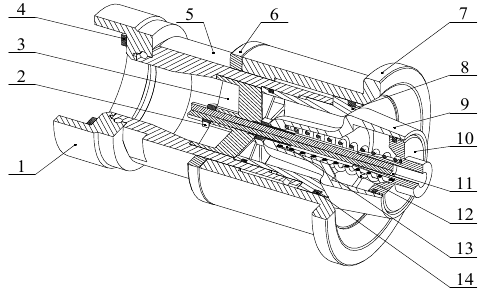
Figure 2. Structure of the new adaptive gun head. 1. Joint; 2. Nut; 3. Regulator; 4. Gasket; 5. Enclosure; 6. Ring; 7. Outer nozzle; 8. Inner nozzle; 9. Spray core; 10. End cap; 11. Core rod; 12. Spring; 13. Core sleeve; 14. Seal ring.